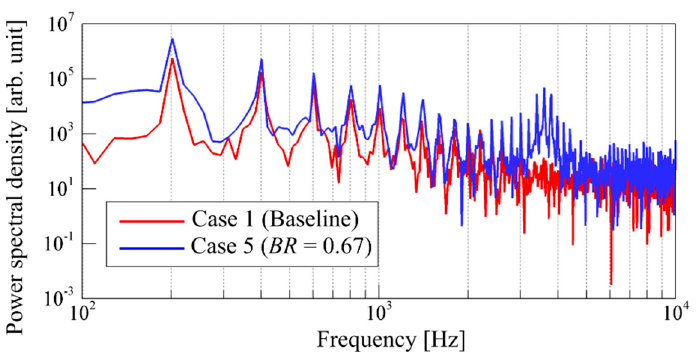
Figure 10. Power spectral density distributions at the coordinate ( x , y ) = (1, 0.5).